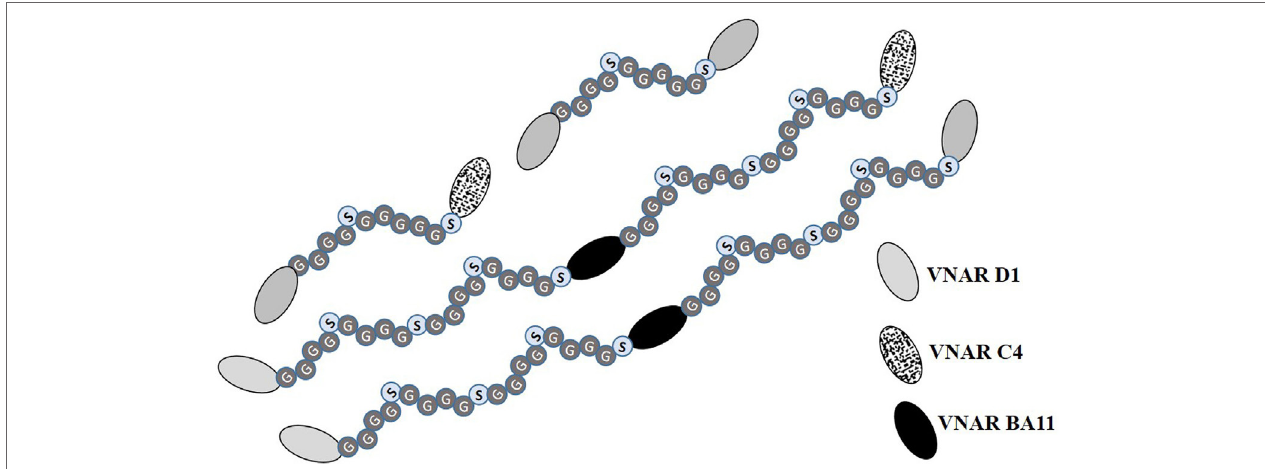
FigUre 2 | Diagrammatic representation of multivalent anti-hTNF- α variable new antigen receptor (VNAR) constructs. Bivalent constructs contain flexible (Gly 4 Ser) 2 linkers while their trimeric counterparts in addition to having flexible GlySer linkers incorporate an anti-human serum albumin (HSA) humanized VNAR (soloMER ™ ), called BA11 (26, 41). This additional anti-HSA binder acts as a spacer and a half-life extension tool for prolonged systemic bioavailibity of the trivalent VNAR. The functional binding of BA11 to HSA was not compromised by the presence, in the expressed fusion protein, of the anti-TNF- α binding VNARs (data not